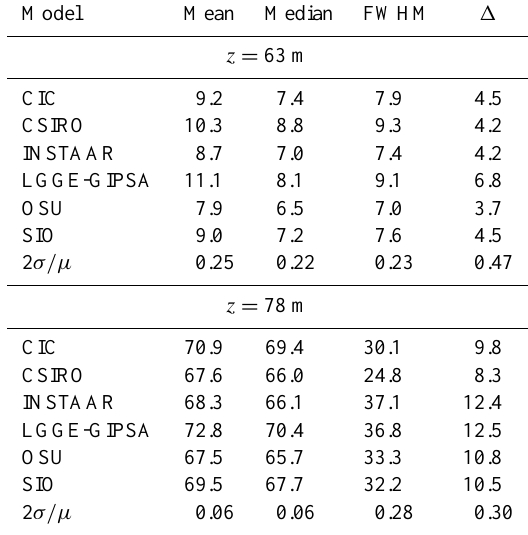
Table 4. Mean age, Median age, Full Width at Half Maximum and Spectral Width ( 1 , Eq. (1) in Trudinger et al., 2002) at the lock-in depth ( z = 63m) and at the bottom of the LIZ ( z = 78m). All values given in years. The 2 σ standard deviation divided by the mean µ gives a measure of the spread in the model